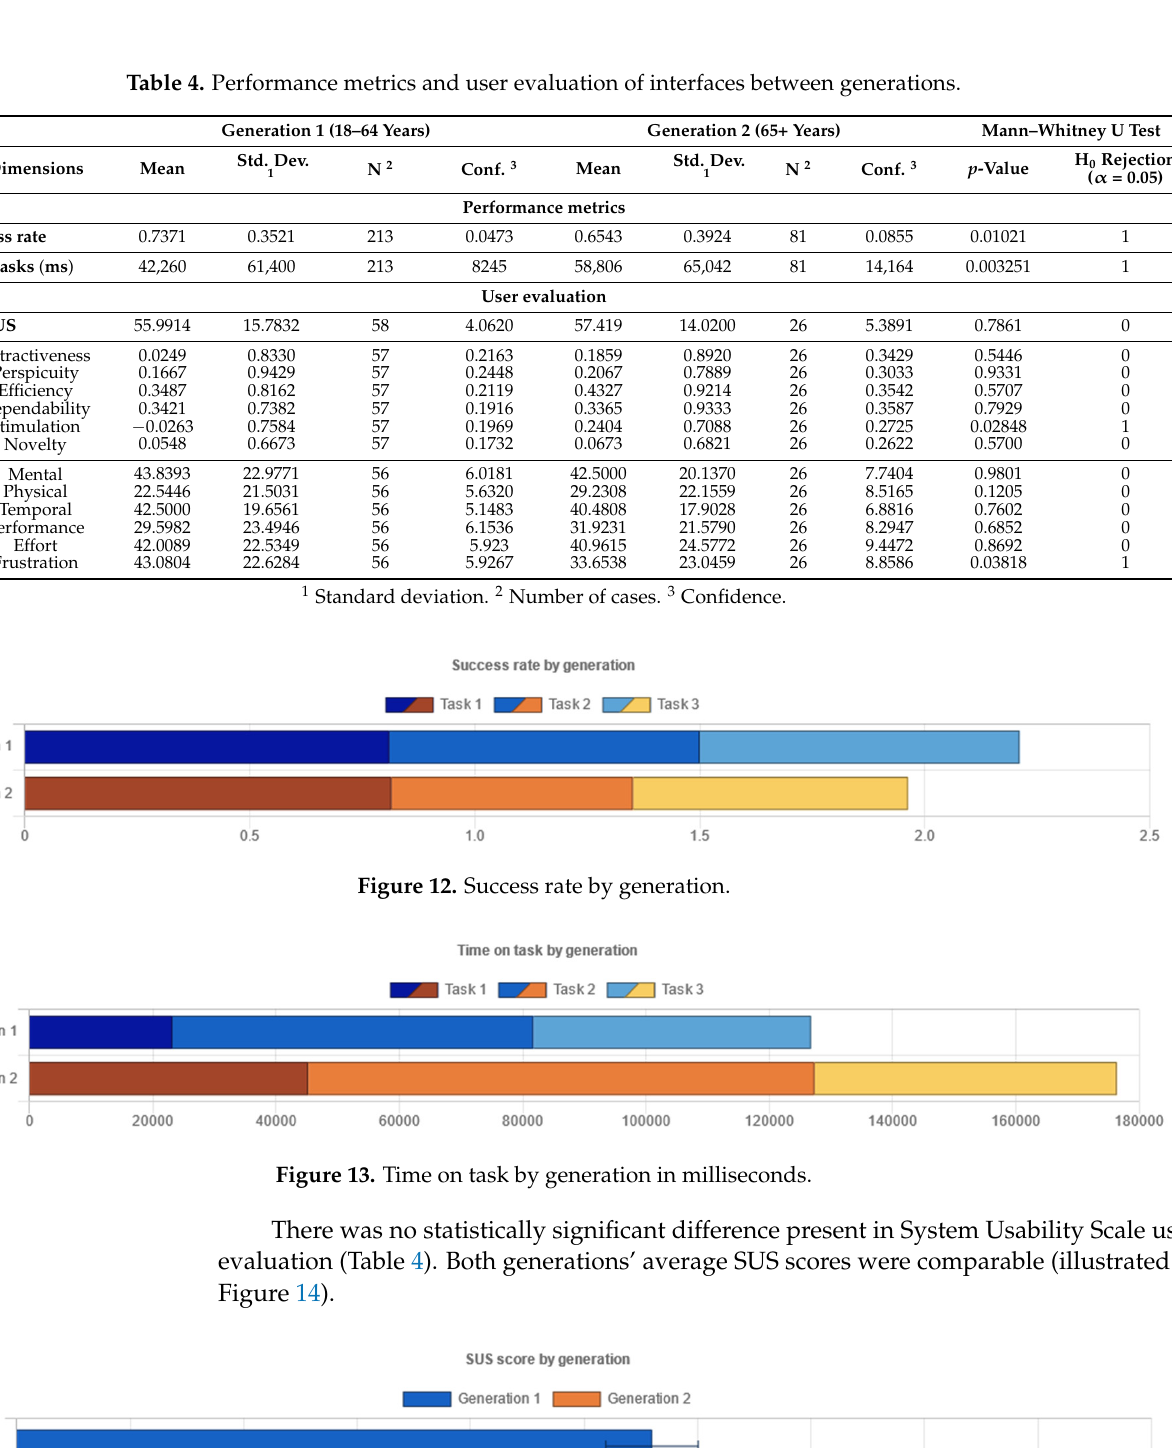
Figure 13. Time on task by generation in milliseconds.